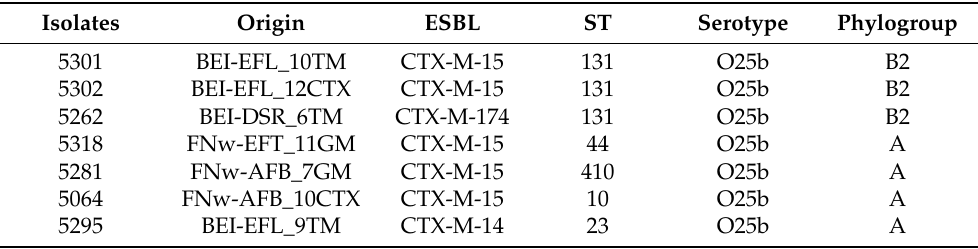
Table 2. Distribution of ESBL-producing E. coli wastewater isolates by multi-locus sequence typing (ST), serotype (O25b), and phylogroups B2 and